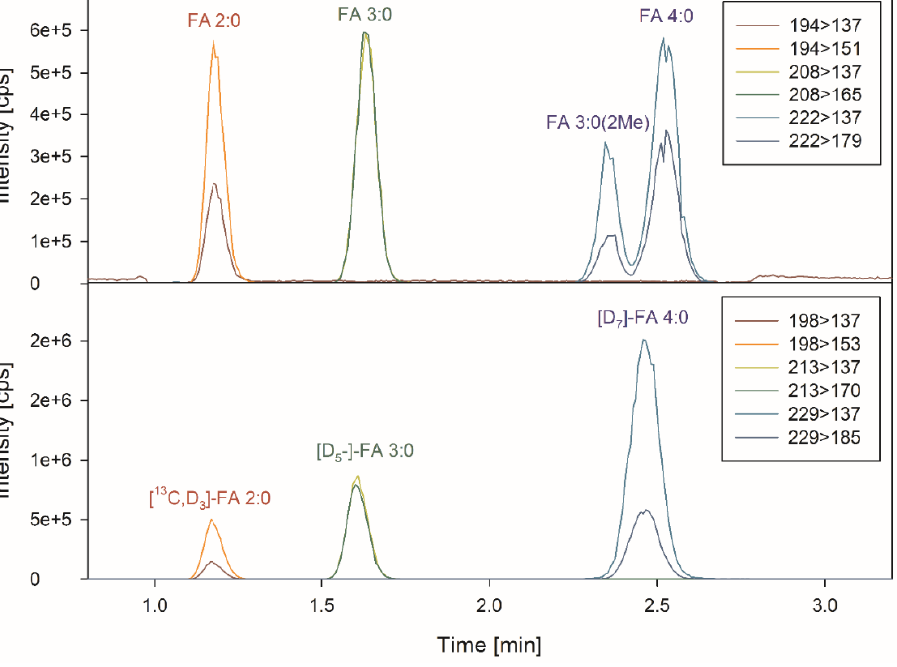
Table 1. LC-MS/MS of the short chain fatty acid (SCFA) – 3-nitrophenylhydrazones (3NPH) derivatives. Displayed are the retention time (RT), mass transitions (quantifier and qualifier ions) of analytes and stable isotope labelled internal standards, declustering potential (DP), and collision energy (CE), as well as the limit of detection (LoD) and highest calibration level for the LC-MS/MS quantification of SCFA – 3NPH derivatives.